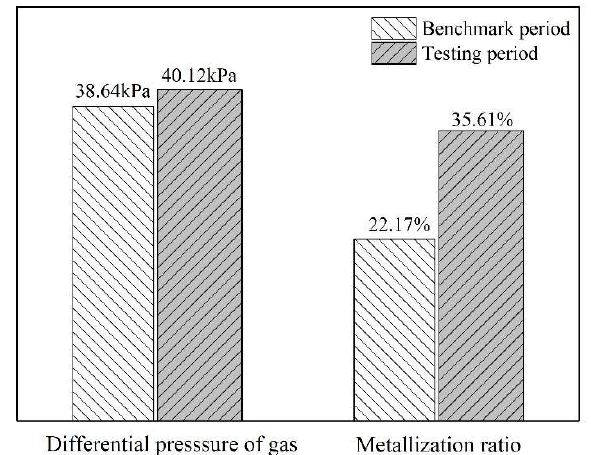
Figure 10. Differential pressure of gas in the shaft furnace and metallization ratio of discharging materials in different periods (11m in height of charge column).